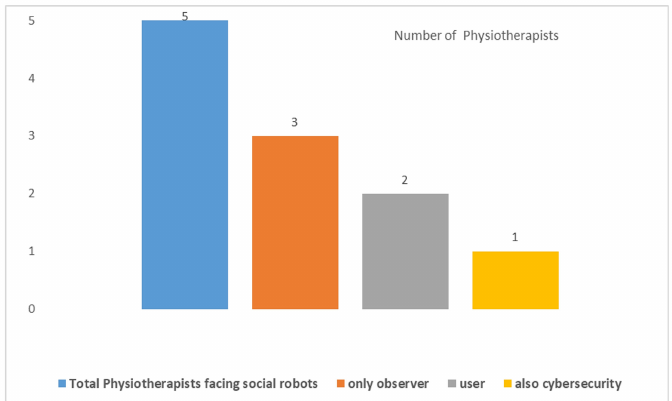
Figure 4. Role of the use of rehabilitation robotics by physiotherapists.